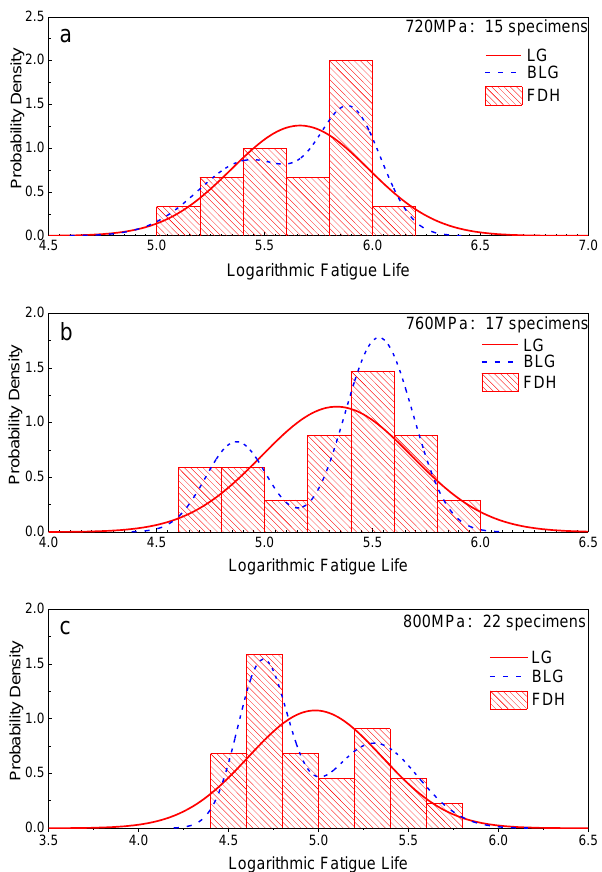
Figure 7. Probability density function (PDF) curves and frequency distribution histograms (FDHs) of specimens under ( a ) 720, ( b ) 760, and ( c ) 800 MPa [26].